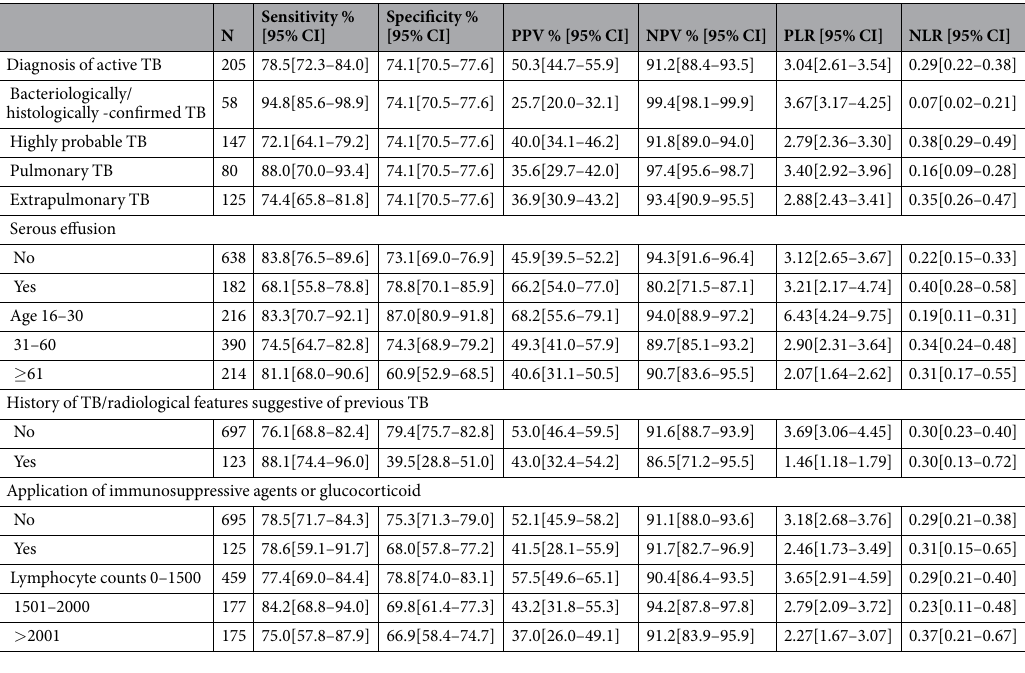
Table 3. Sensitivity, specificity, PPV, NPV of ELISPOT (T-SPOT.TB) for diagnosis of active tuberculosis. PPV: Positive predictive value; NPV: Negative predictive value; PLR:Positive likelihood ratio; NLR: Negative likelihood ratio.